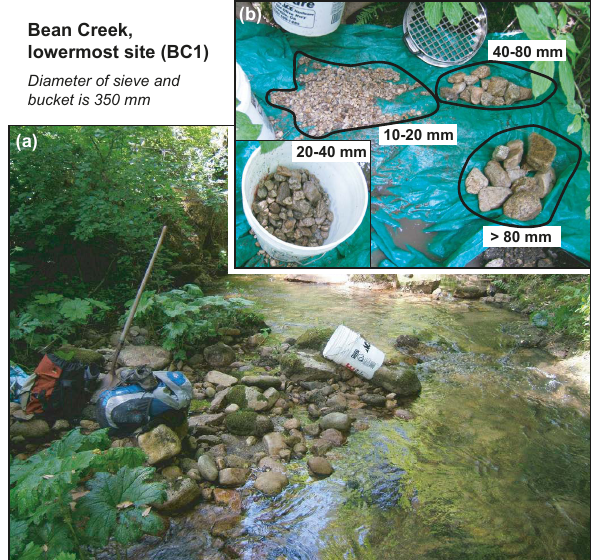
Figure 6. Example of gravel bar investigated in this study (site BC1 on Bean Creek). (a) Overview and (b) sediment after